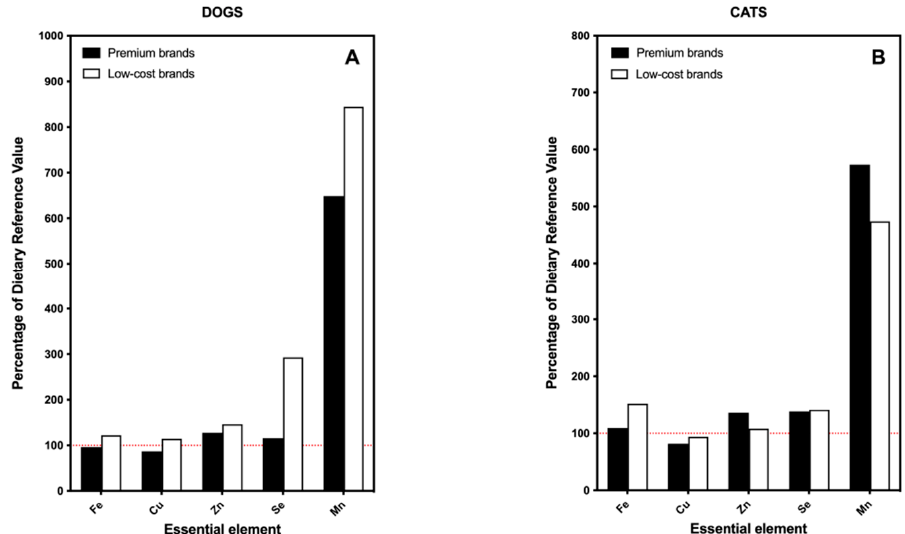
Figure 1. Bar plot indicating the percentage of the DRV of essential elements provided by the consumption of commercial dry food separated by the type of brand: premium vs. low-cost brands. ( A ) Results for dogs; ( B ) results for cats. Red dotted line indicates 100% of the DRV for each ele- ment.